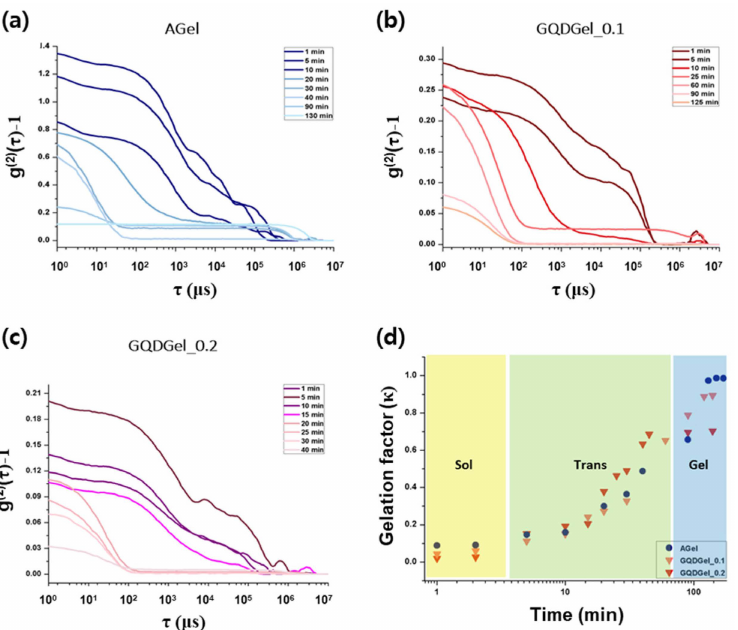
Figure 3. Dynamic light scattering analysis for hydrogel samples. time − intensity correlation function (g (2) ( τ )–1) of ( a ) AGel, ( b ) GQDGel_0.1, and ( c ) GQDGel_0.2 with increase of exposure time under sunlight. ( d ) Plot of gelation factor ( κ ) of each sample as a function of time. To compare the microstructures of AGels with those of GQDGels, the cross-sectional view of AGel and GQDGel_0.2 samples were observed by SEM, which showed a highly porous structure with pore sizes ranging from a few to tens of micrometers (Figure 4). The pore size of the hydrogel was dependent on the ratio of monomer (AA) to crosslinking agent (MBAA); as the ratio of AA to MBAA increased, the pore size of the